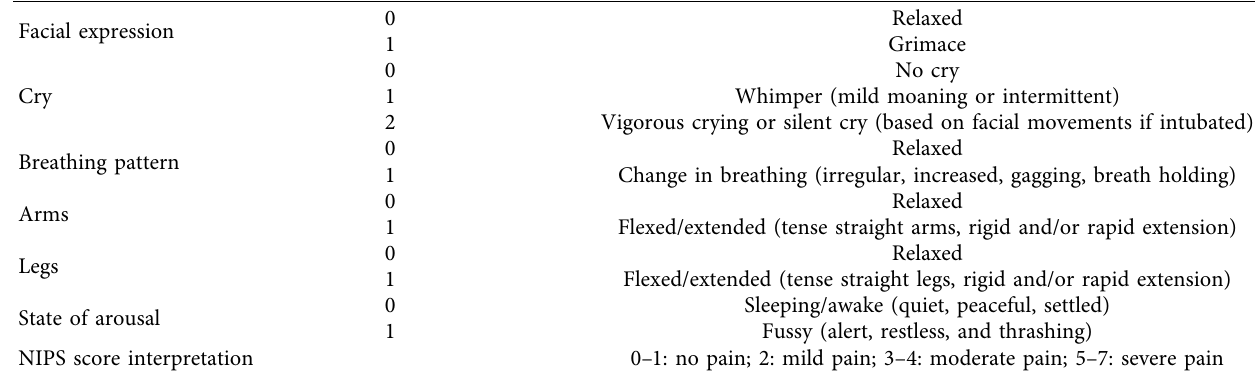
Table 1: Scoring and interpretation for the NIPS